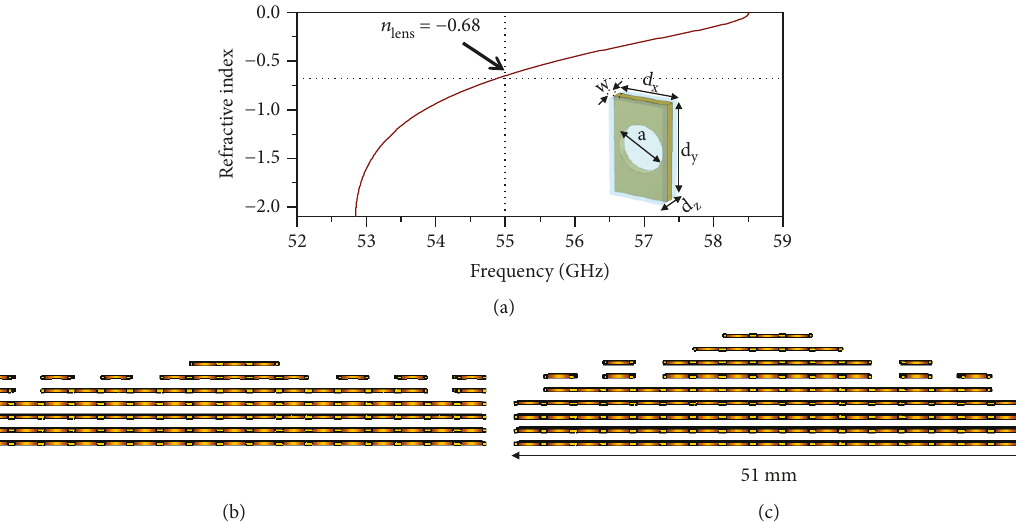
Figure 1: Dispersion diagram of the unit cell and pro fi les of the metalenses. (a) Refractive index of the fi shnet structure used to design the lenses, assuming it to be in fi nitely periodic. Unit cell (inset) with dimensions: d x = 3 mm , d y = 5mm , d z = 1 35 mm , and a = 2 4 mm . The thickness of the metal is w = 0 35 mm . Top view of the schematic representation of the reversed-phase zoned fi shnet metalenses with (b) q = 0 and (c) q = 0 35 .